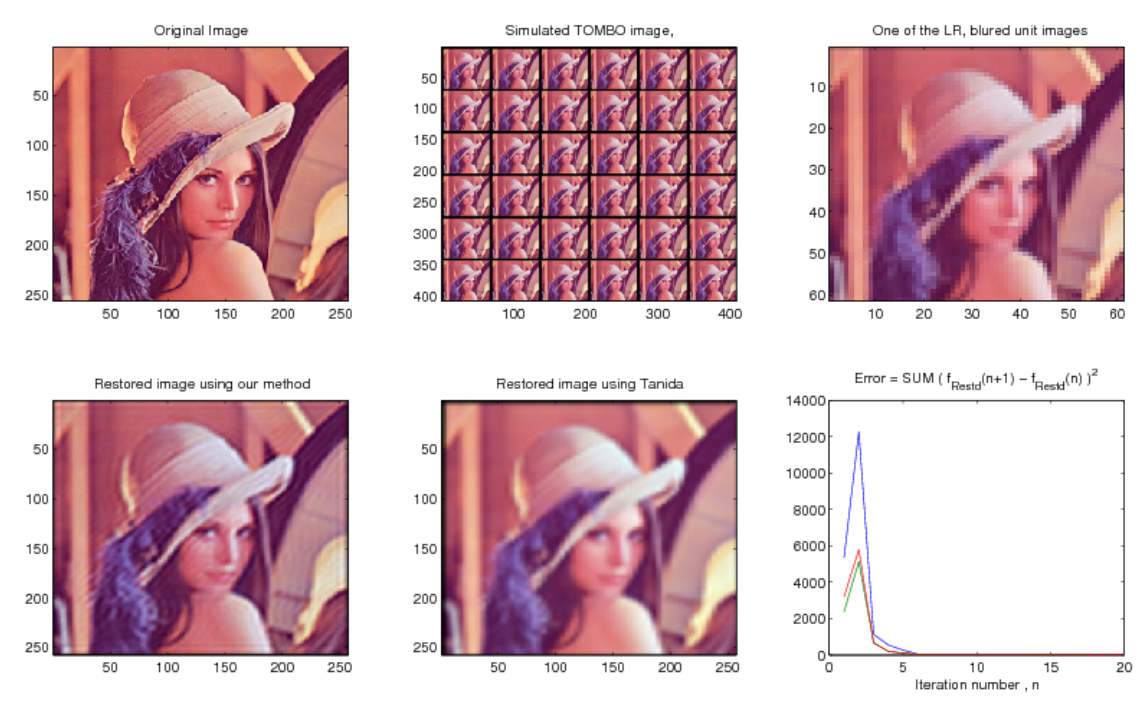
Figure 5. Simulation results, 6 × 6 images, D = 4 , L = 4 , ‘ = 7 , SNER = 4.968